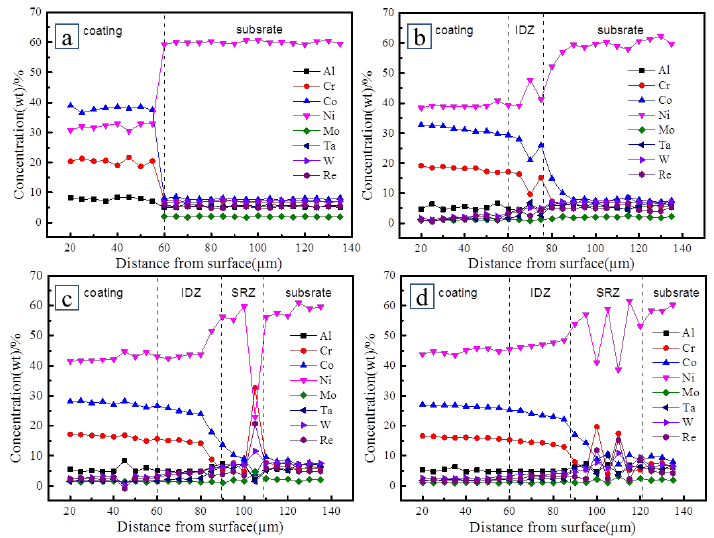
Figure 6. Energy dispersive spectrometer (EDS) elemental concentration profiles of NiCoCrAlY coating / N5 single crystal superalloy with depth from coating to substrate after static oxidation at 1100 °C: ( a ) 0 h; ( b ) 50 h; ( c ) 100 h; ( d ) 200 h.